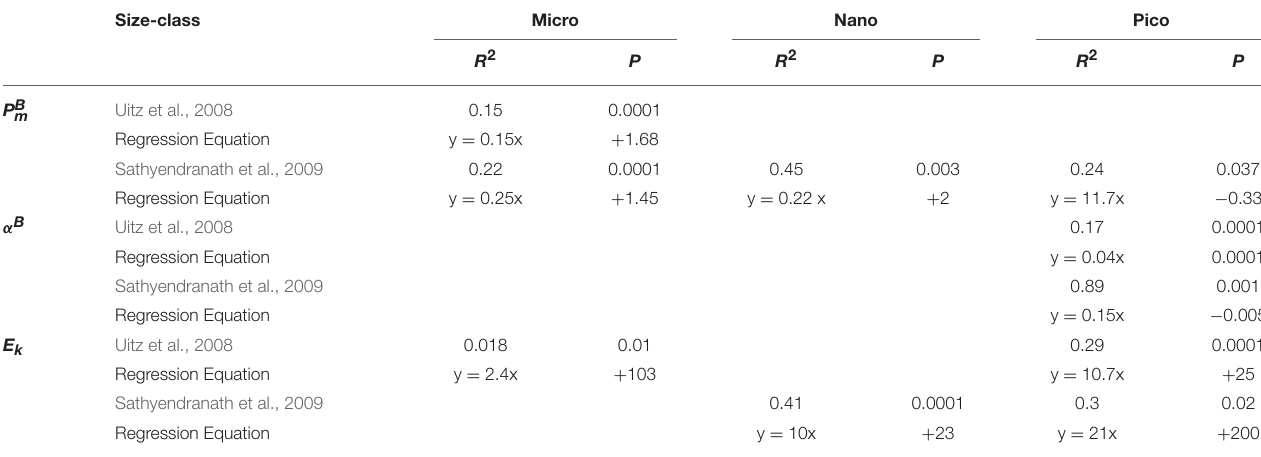
TABLE 3 | Significant regression equations between size class photosynthetic parameters and temperature.